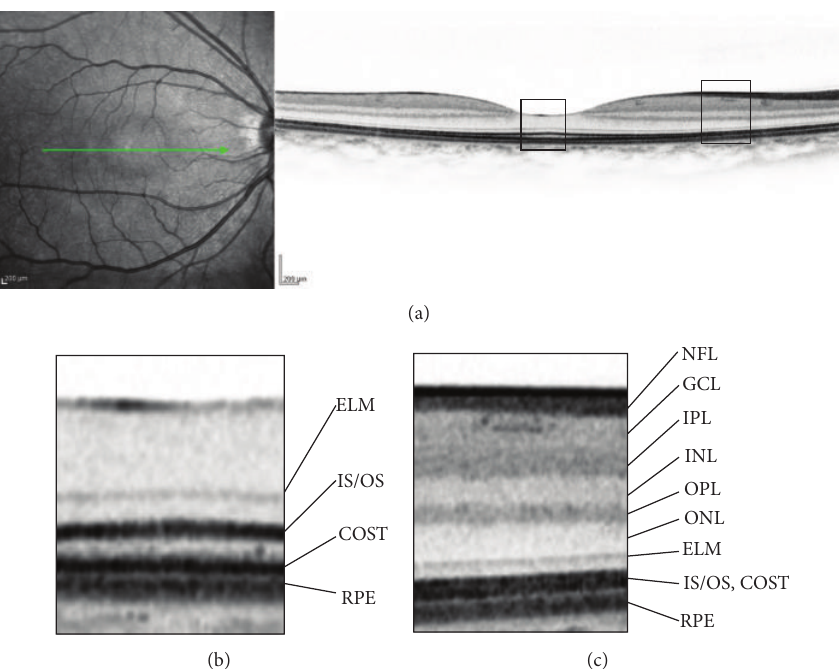
Figure 1: (a) Retinal sections of the physiologic macula dissecting along the green line on fundus photography using SD-OCT. (b) The magnified image at the fovea shows three lines over the retinal pigment epithelium (RPE), that is, the external limiting membrane (ELM), the junction between inner and outer segments (IS/OS), and the cone outer segment tips (COST). (c) A magnified parafoveal image shows the individual retinal layers. NFL: nerve fiber layer; GCL: ganglion cell layer; IPL: inner plexiform layer; INL: inner nuclear layer; OPL: outer plexiform layer; ONL: outer nuclear